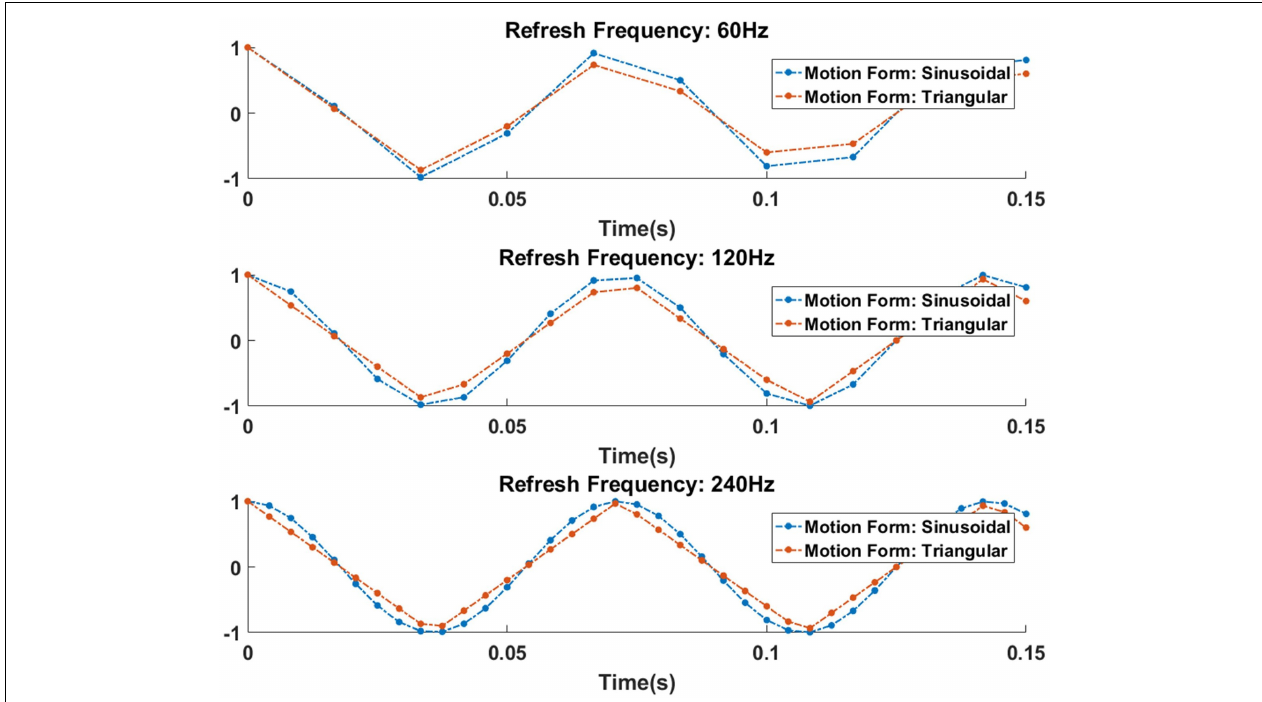
FIGURE 10 | The similarity of sinusoidal and triangular motion at different refresh rates. The vertical axis indicates displacement of stimulation, and the horizontal axis indicates stimulation